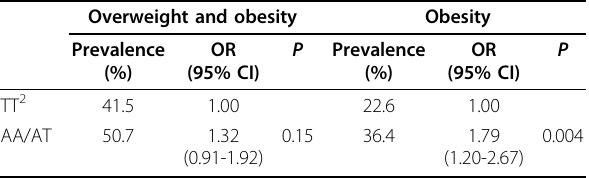
evidence of association between rs9939609 and other Table 2 Associations of the FTO variant with overweight